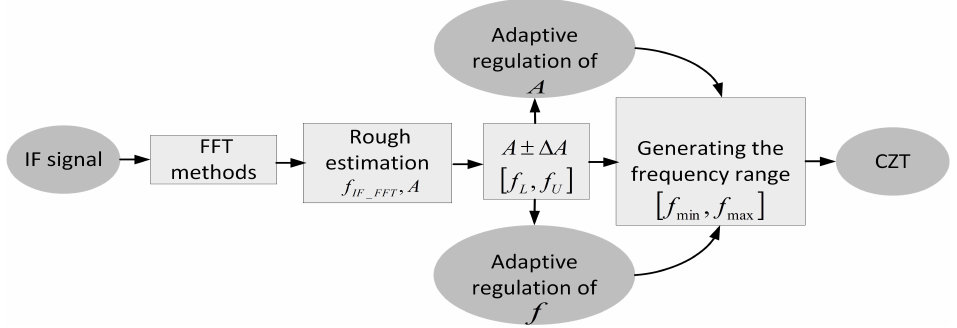
Figure 7. Algorithm flow for